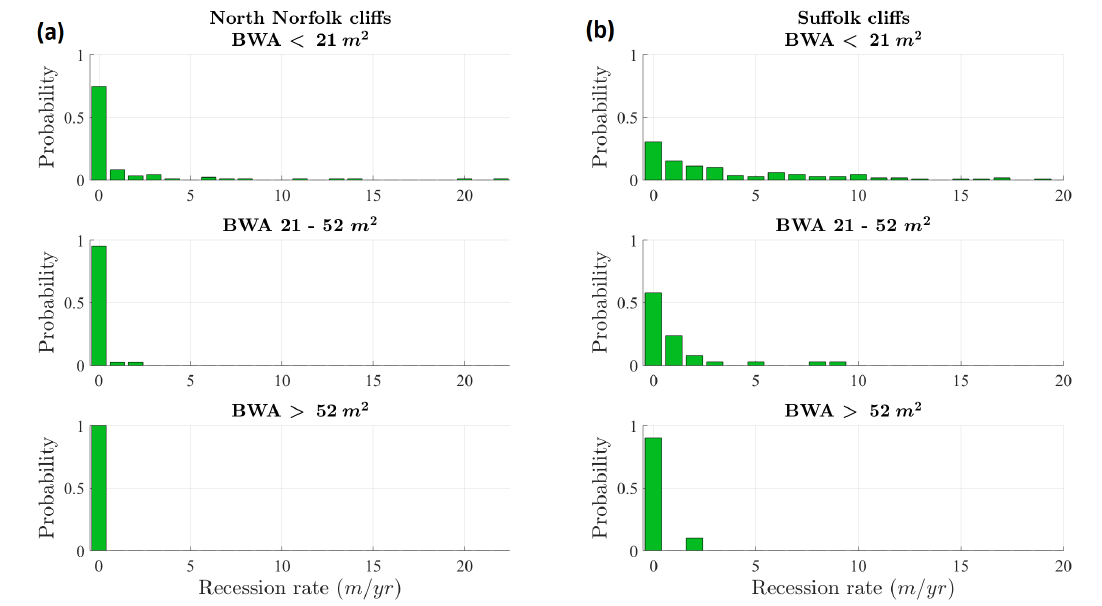
Figure 7. Annual scale probability distribution for cliff top recession rates sub-divided into different BWA ranges (based on clustering analysis) for North Norfolk ( a ) and Suffolk ( b ) cliffs using data from 1993 to 2018. The probability histogram is based on intervals of 1 m/year for recession rates. We used the updated MHWS values for the BWA